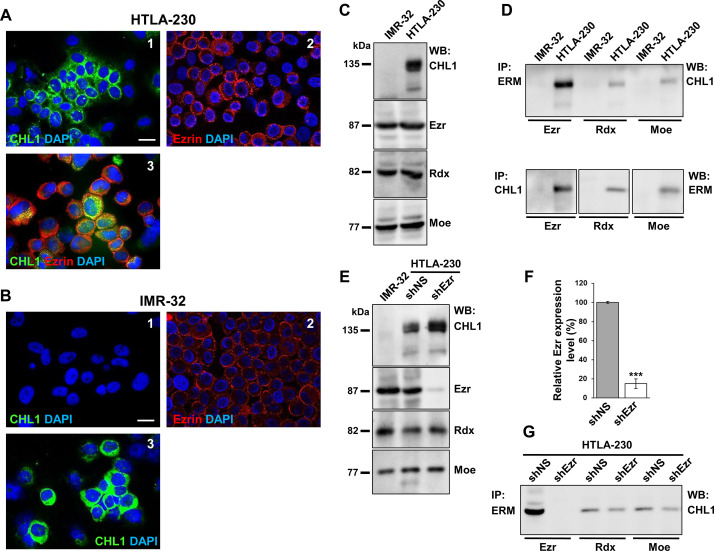
Ezrin-CHL1 localization and interaction in NB cells.Immunofluorescence analysis of CHL1 and ezrin plasma membrane localization on (A) HTLA-230 and (B) IMR-32 cells using anti-CHL1 (green) (1) or anti-ezrin (red) (2) antibodies. HTLA-230 in photo A3 were double stained for CHL1 and ezrin (yellow, merge). IMR-32 in photo B3 expressed the transfected pCEFL-CHL1 molecule. Cells were counterstained with DAPI to visualize nuclei (blue) (Scale bars: 10 μm) (C) IMR-32 and HTLA-230 cells were lysed and subjected to Western blot (WB) analysis with anti-CHL1, anti-ezrin (Ezr), anti-radixin (Rdx), and anti-moesin (Moe) antibodies. Only HTLA-230 cell line displayed expression of endogenous CHL1 protein, whereas the three ERM proteins (Ezr, Rdx, and Moe) were equally expressed in both cell lines, and each of them was used as a loading control. (D) Cells lysates were subjected to each anti-ERM protein immunoprecipitation (IP) followed by anti-CHL1 Western blot or to anti-CHL1 immunoprecipitation followed by each anti-ERM protein Western blot. (E-F) Cell lysates from IMR-32 (as CHL1 negative control), and from HTLA-230 transfected with shNS (as non-silencing control) or shEzr, underwent Western blot analysis with anti-CHL1 and each anti-ERM protein antibody. HTLA-230 cells were lysed 7 days after transfection. 85–90% reduction in total ezrin levels was achieved compared to the non-silenced control, considered as 100%, whereas radixin and moesin levels did not change and they were used as loading controls. Data are representative of three independent experiments ± SD (*** p < 0.001). (G) Cell lysates from HTLA-230 transfected with shNS or shEzr were subjected to each anti-ERM protein immunoprecipitation followed by anti-CHL1 Western blot. All the immunoprecipitation results are representative of three independent experiments.